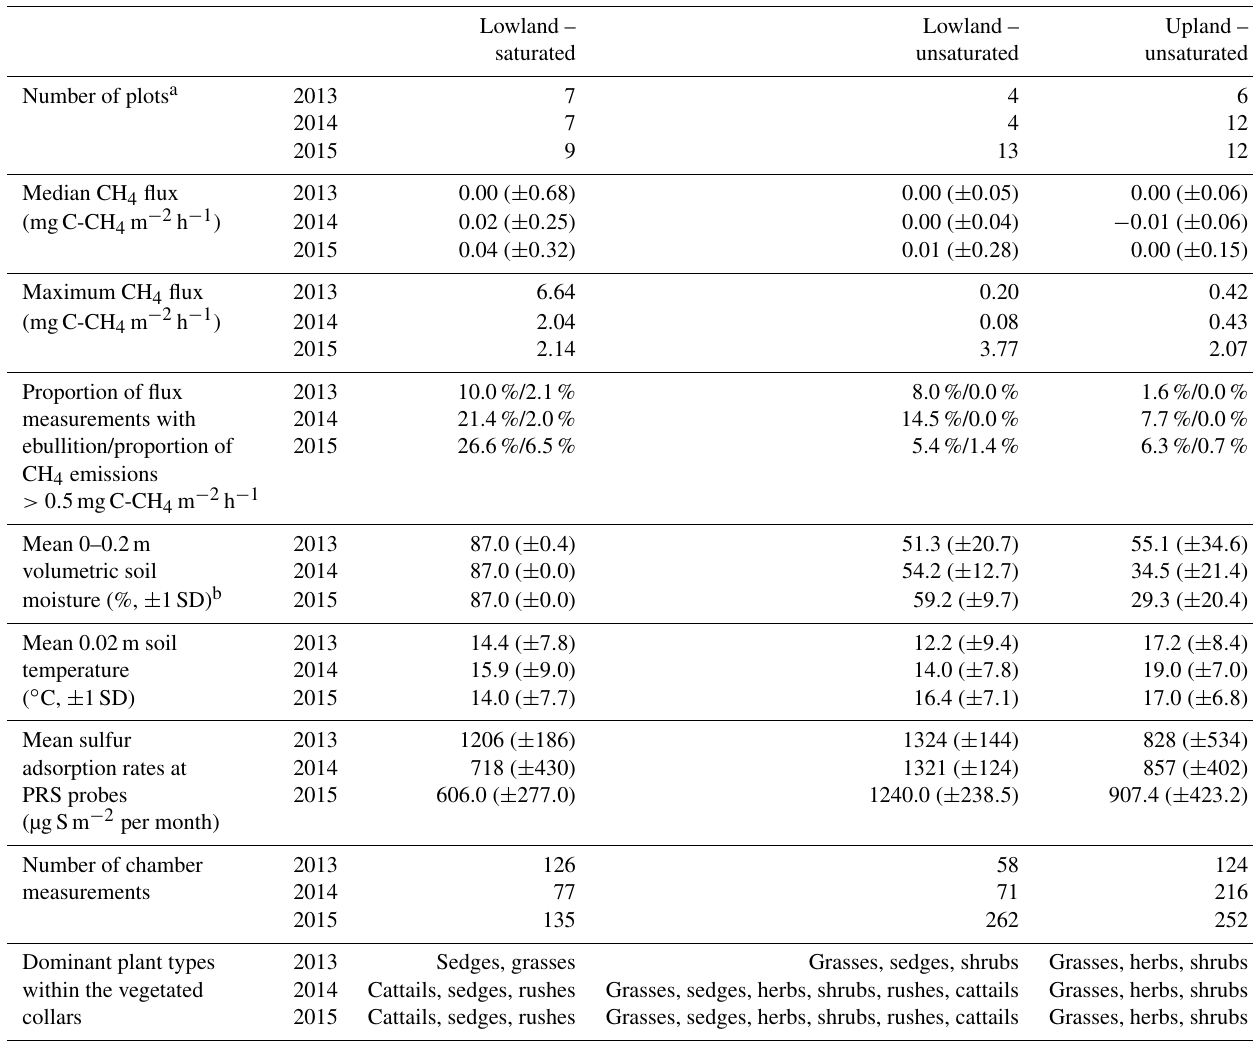
Table 1. Soil and CH 4 flux characteristics of the three location groups. The standard deviation from the mean is reported in brackets. Dominant vegetation is the most common plant type among the vegetated collars (by percentage of